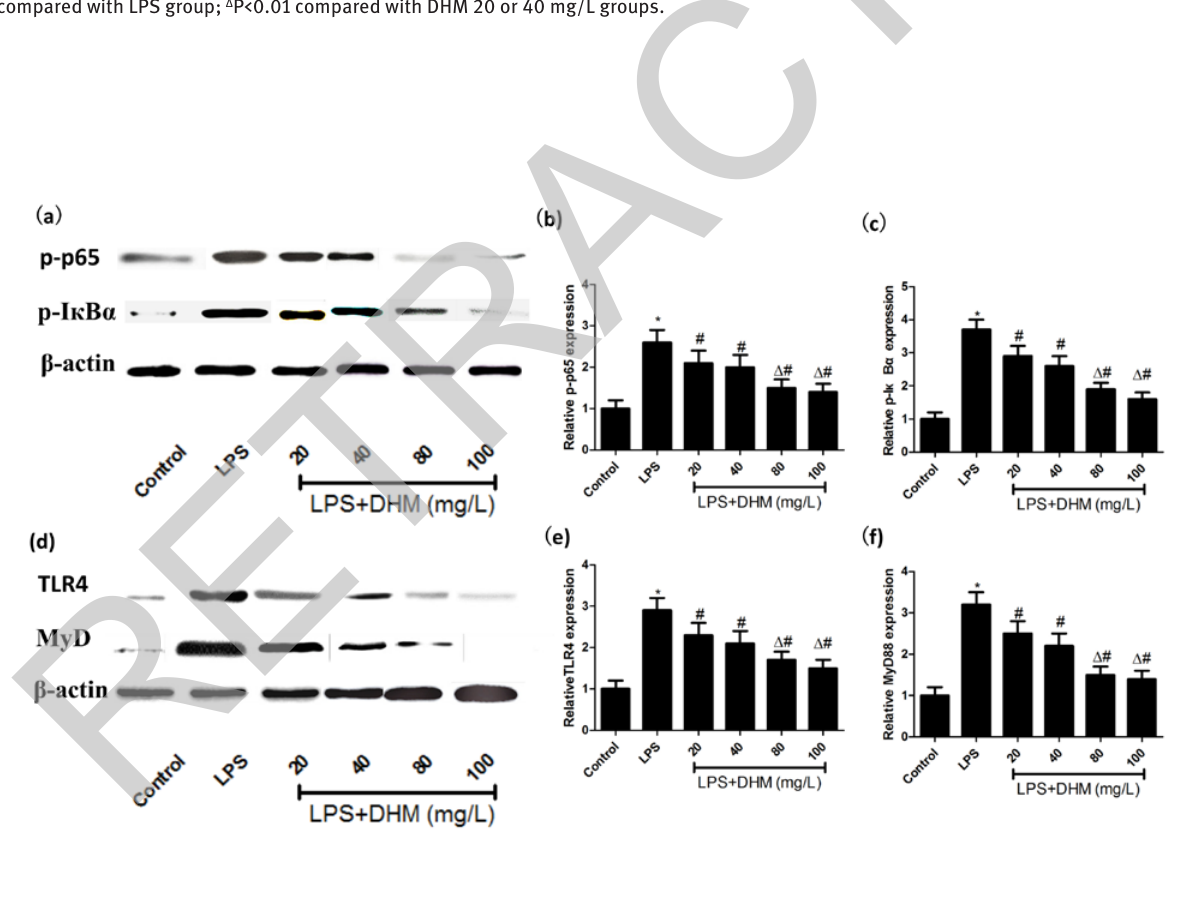
Figure 4: The effects of various concentrations of DHM (20, 40, 80 or 100mg/L) on NF-κB and toll-like receptor 4 (TLR4) signaling. (a-c) The activation of NF-κB induced by LPS was attenuated by DHM (20, 40, 80 or 100mg/L). (d-f) The activation of TLR4 signaling induced by LPS was attenuated by DHM (20, 40, 80 or 100mg/L). *P<0.01 compared with control group; # P<0.01 compared with LPS group; Δ P<0.01 compared with DHM 20 or 40 mg/L